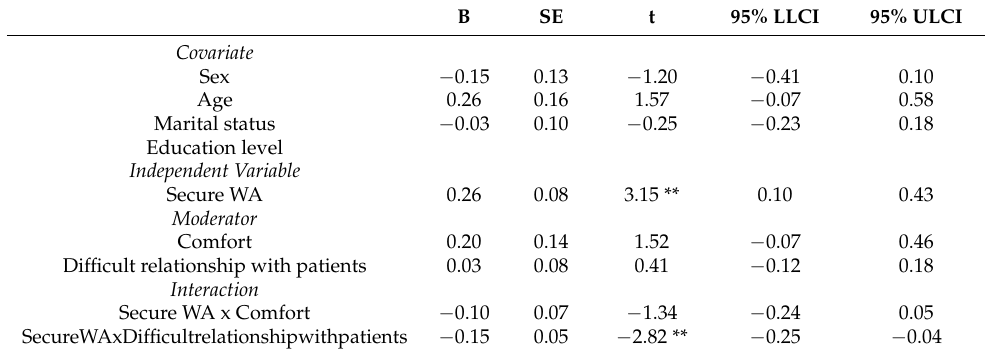
Table 4. Moderation model with secure WA as IV and Civic Virtue as